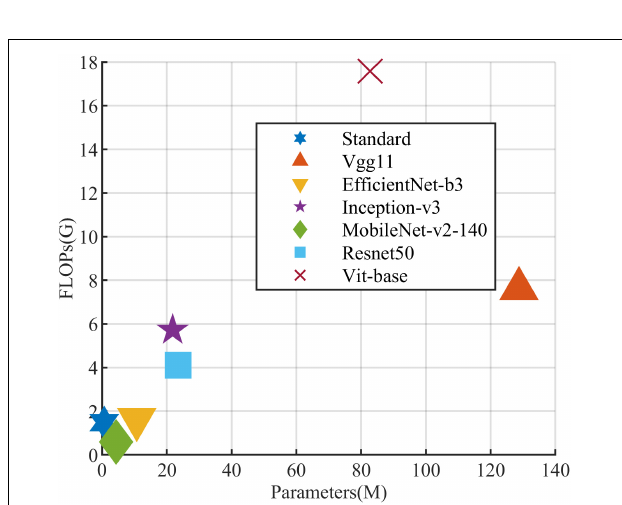
FIGURE 8 | Comparison of the standard model and the other models in parameters and